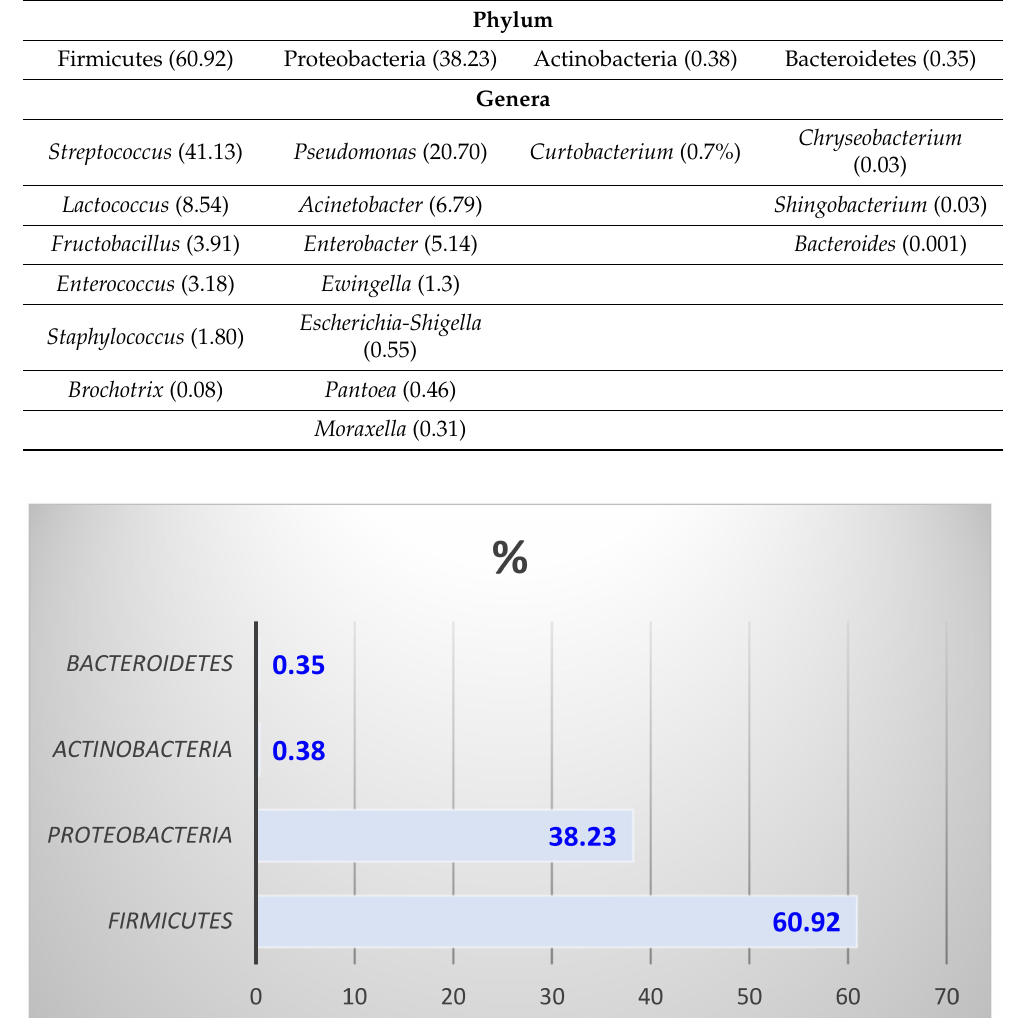
Table 2. Abundance percentage (%) in the microbiome analyses of ewe’s milk lump cheese.